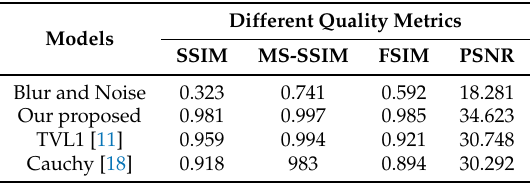
Table 3. Different image quality metrics for blurred and noisy Phantom images and recovered